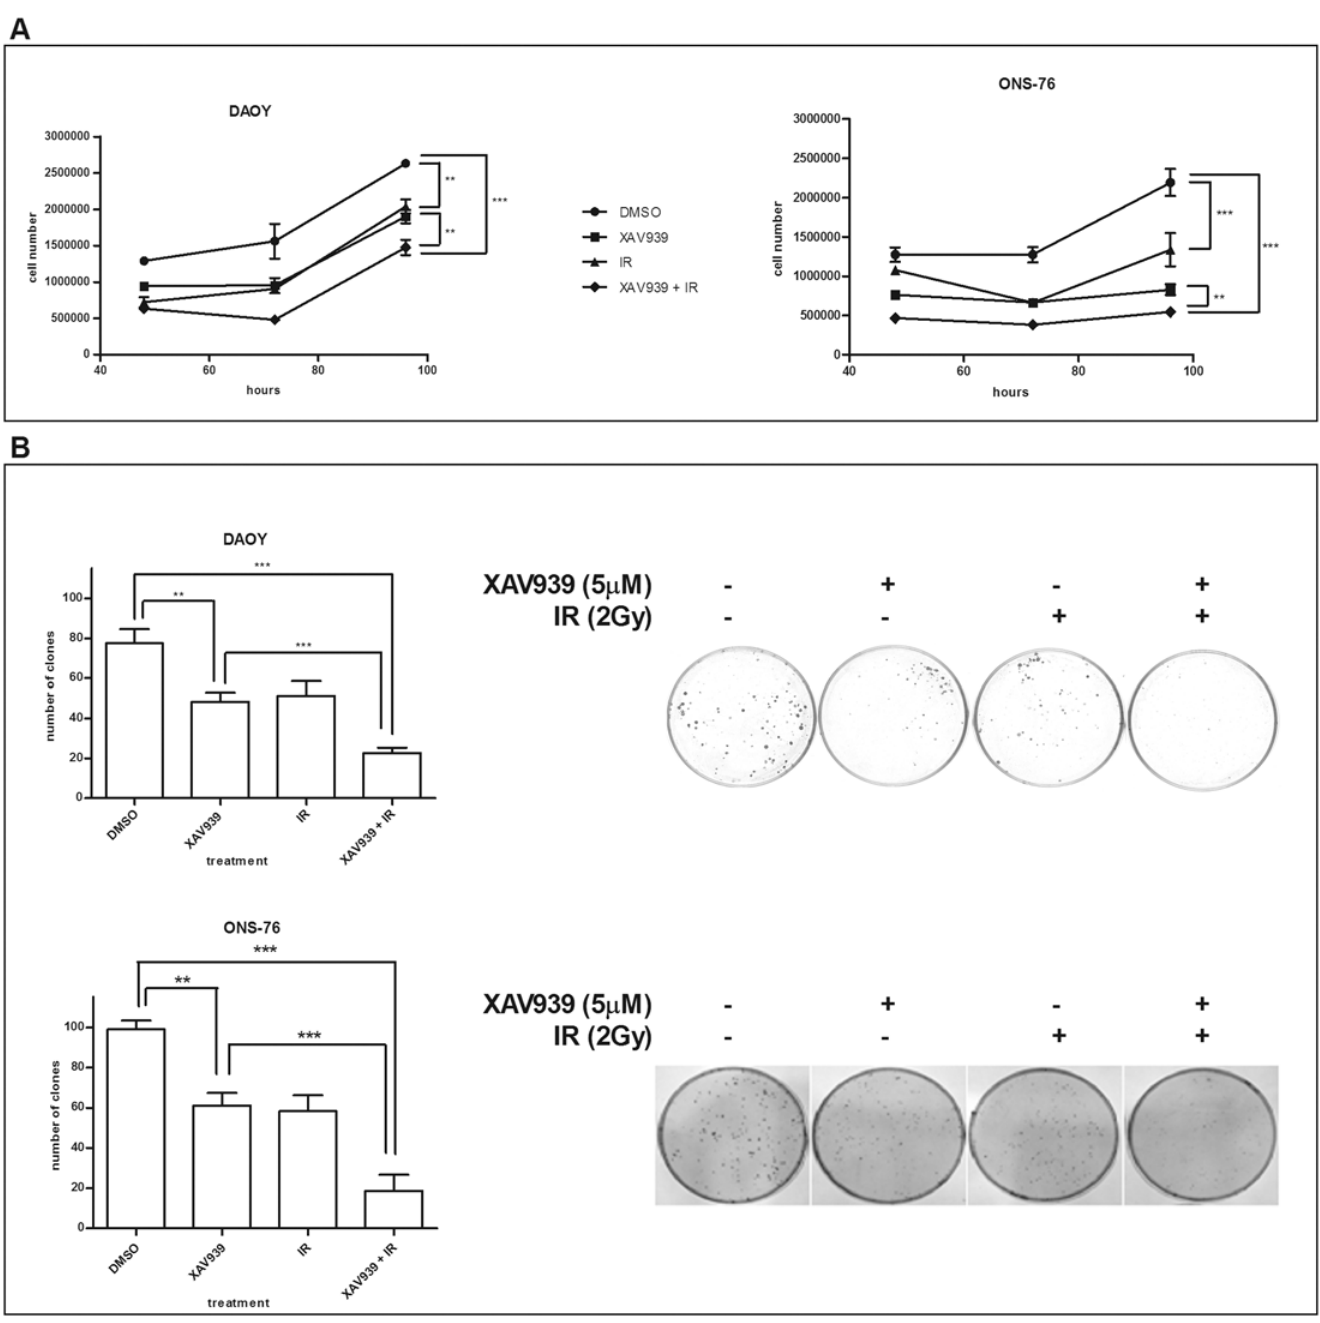
Fig 2. XAV939 impairs the clonogenic and proliferative capacity and enhances MB cells radio-sensitivity. A. Growth curves assay . XAV939 (5 μ M) treated cells and IR (2 Gy) treated cells showed a similar growth rate with about 40% (DAOY) and 30% (ONS-76) reductions compared to DMSO control cells ( p < . 01). In both cell lines, the co-administration of XAV939 and IR induces a massive cell proliferation inhibition with a decrease of about 70% ( p < . 001). Each point represents the mean ± s.e. of three independent assays. B. Clonogenic forming assay . XAV939 alone (5 μ M) inhibits a clone-forming ability in both MB cell lines as well as IR treatment (2 Gy), with a clonogenic capability reduction of about 38% ( p < . 01). The IR and drug co-administration induces a drastic inhibition of clone-forming in both cell lines (70% reduction in DAOY cells and 81% in ONS-76 compared with control cells, p < . 001).